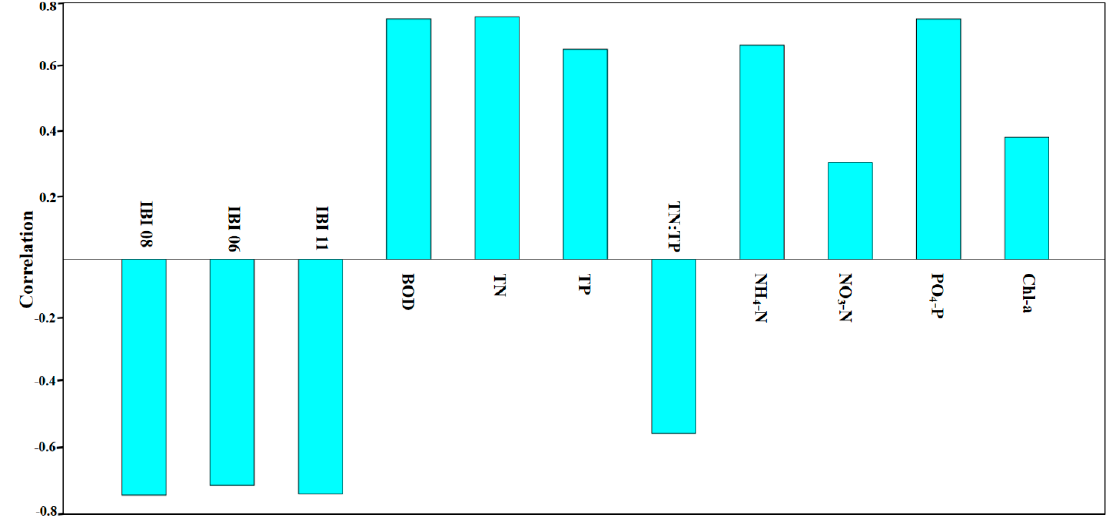
Figure 5. Loading plot for IBI models and selected water chemistry features in Geum River watershed.